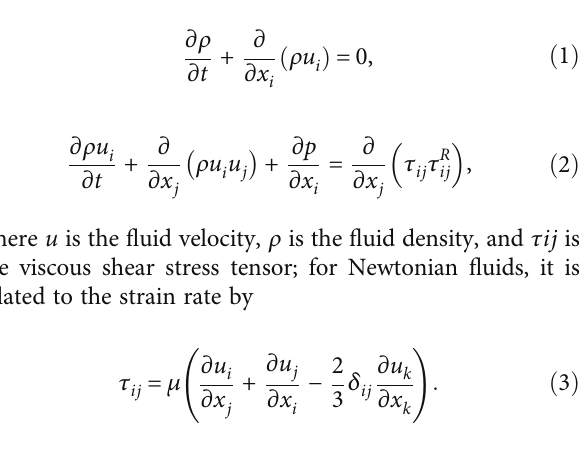
Figure 12: PAT blade inlet